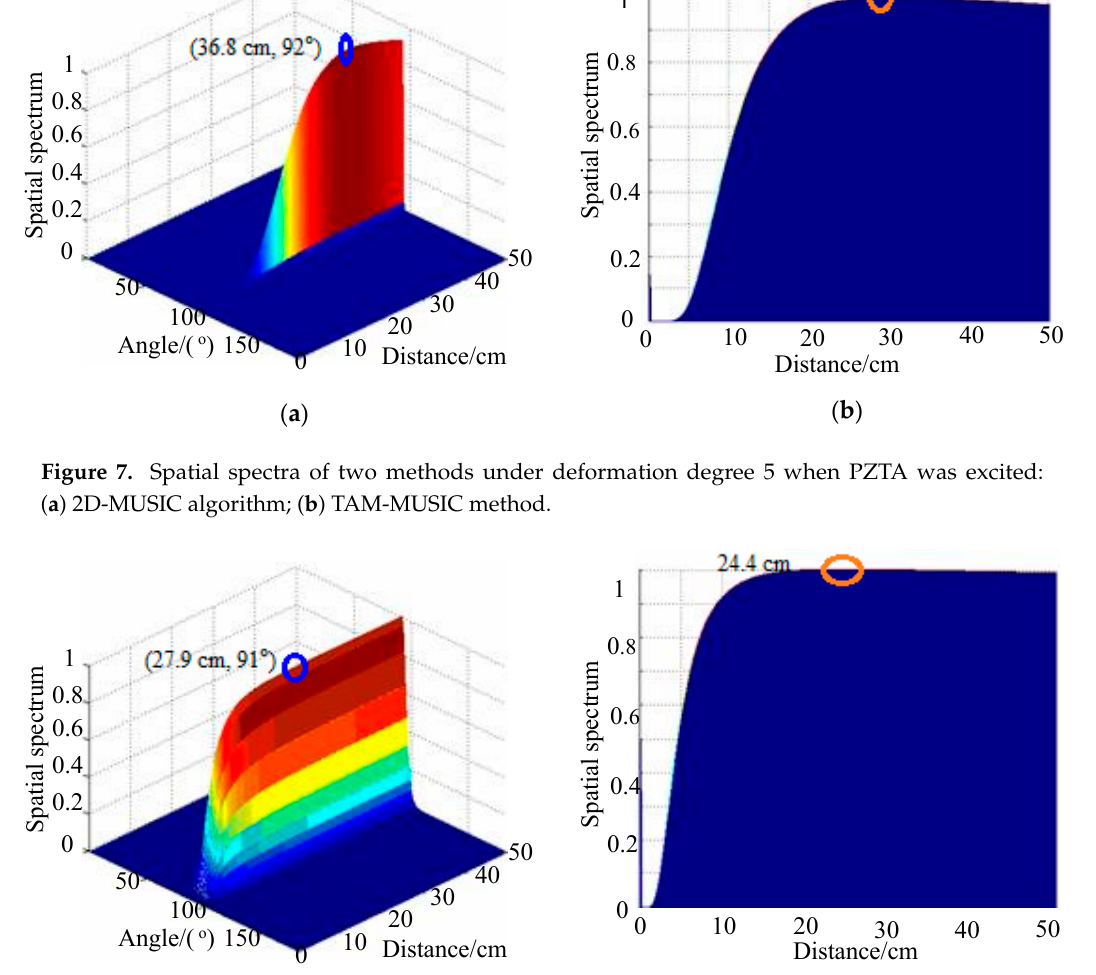
Figure 6. Block diagram of present TAM-MUSIC approach.